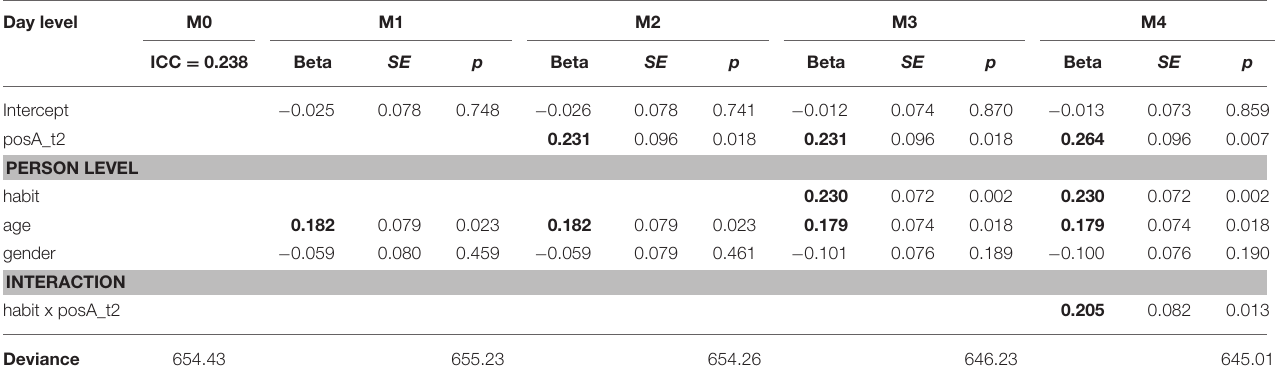
TABLE 1 | Model 1.1: Prediction of objective after work MVPA by positive affect and habit strength. Day level